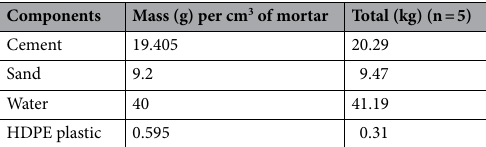
Table 2. Representative mortar mix design for HDPE plastic at 10% cement replacement. Additional mix ratios are shown in Table S2.